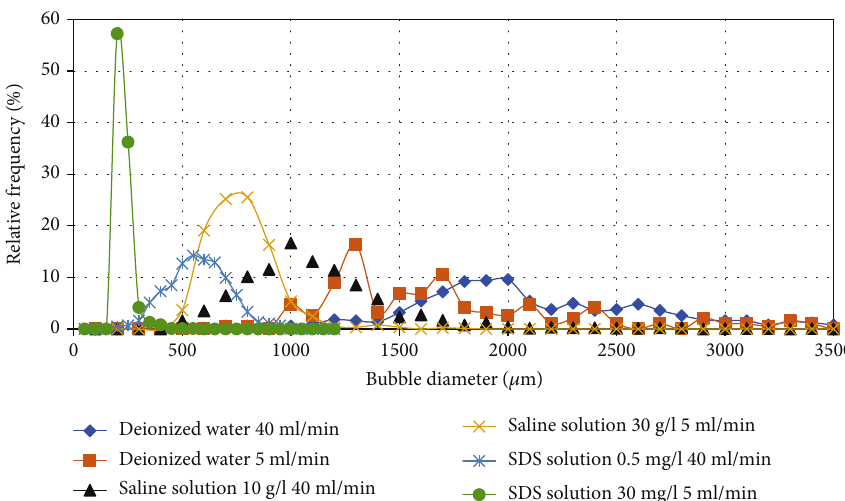
Figure 5: Overall comparison between the solute-added solutions (SDS surfactant and saline water solutions) and deionized water for the highest and lowest gas injection